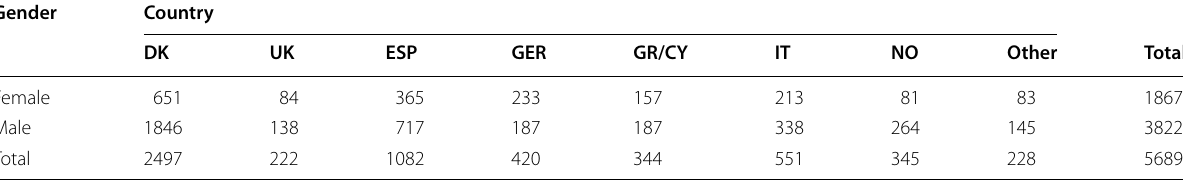
Table 2 Distribution of respondents by country